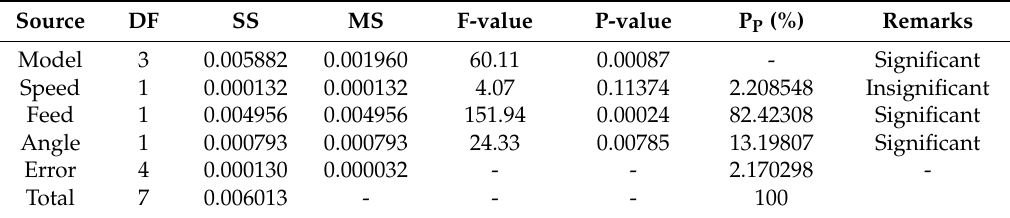
Table 6. ANOVA results for